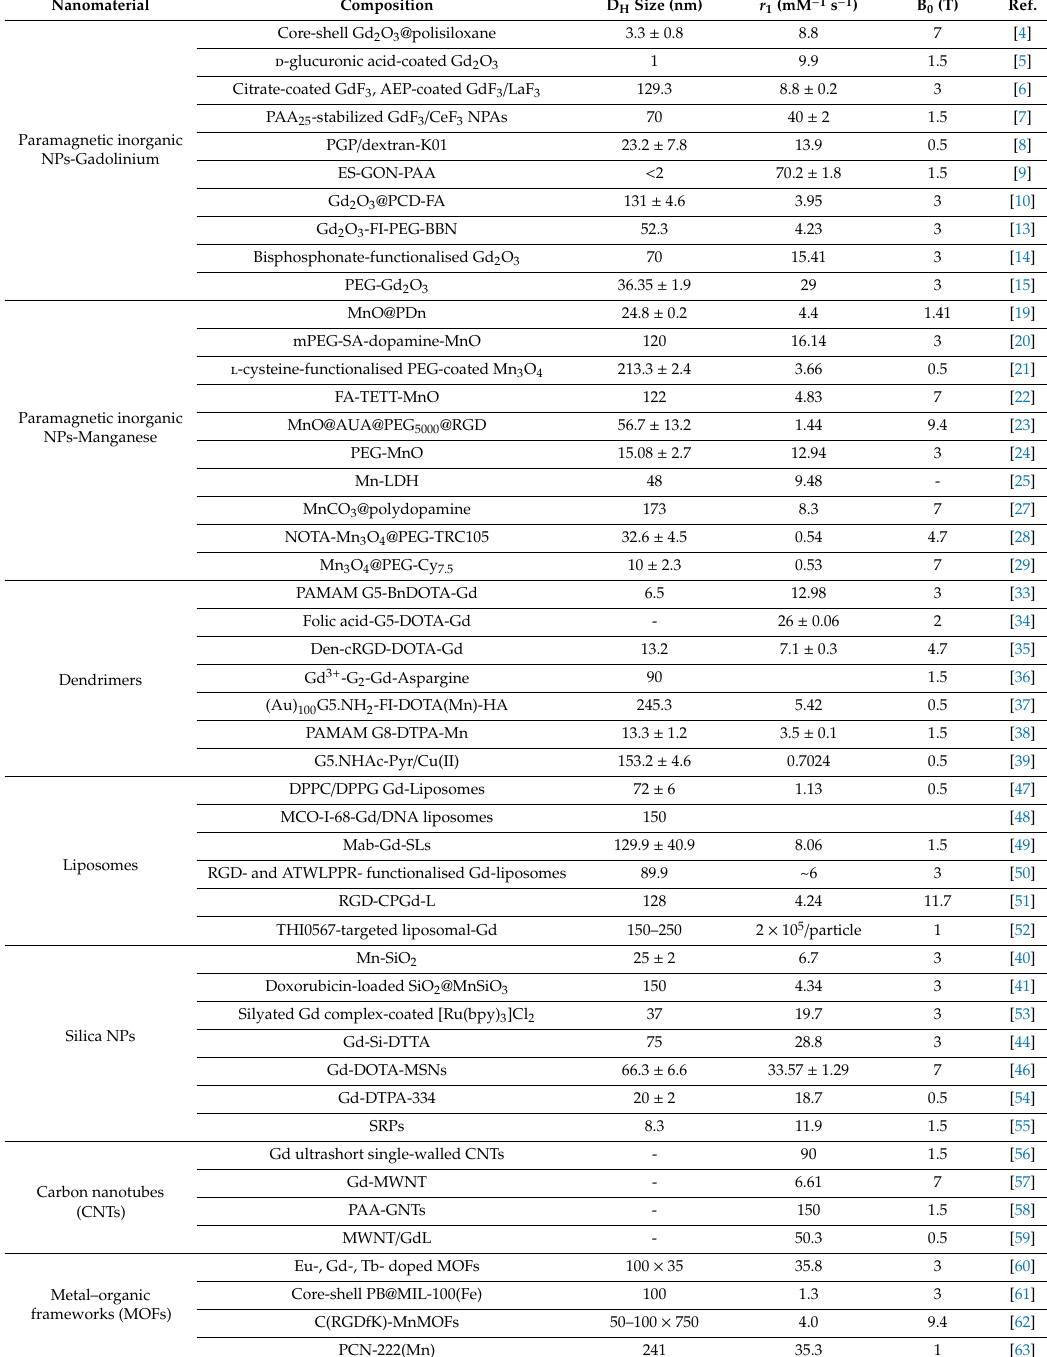
Table 2. Composition, hydrodynamic diameter (D H , nm) and r 1 (mM − 1 s − 1 ) at magnetic field B 0 (T) of some reported T 1 based